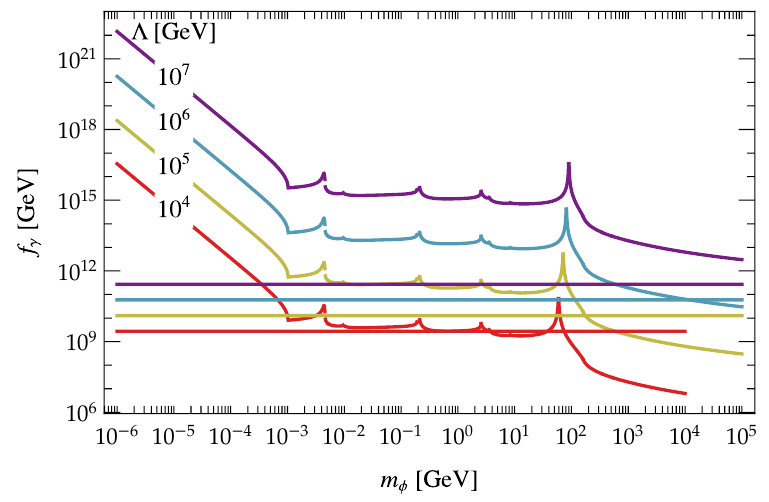
Figure 7 . Relaxion e(cid:11)ective coupling to photons, ( (cid:30)=f (cid:13) ) F e F , given in eq. (4.4) as a function of the relaxion mass for di(cid:11)erent cuto(cid:11) scales from (cid:3) = 10 4 GeV (lowest, red) to (cid:3) = 10 7 GeV (upmost, purple). The dilution condition (eq. (4.6)) is satis(cid:12)ed above the horizontal lines which set the bound for the di(cid:11)erent the (cid:3) scales showed in the